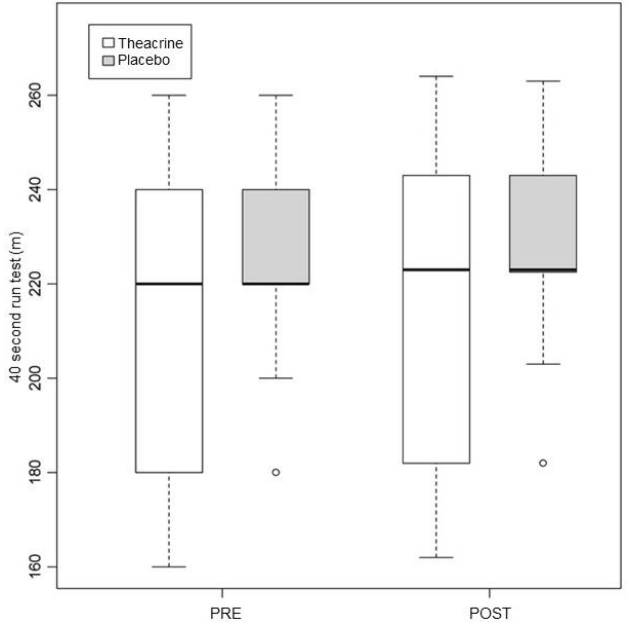
Figure 5. Alterations in performance in the 40 s run in the first and second assessments. Values expressed in median – interquartile interval. m = meters.